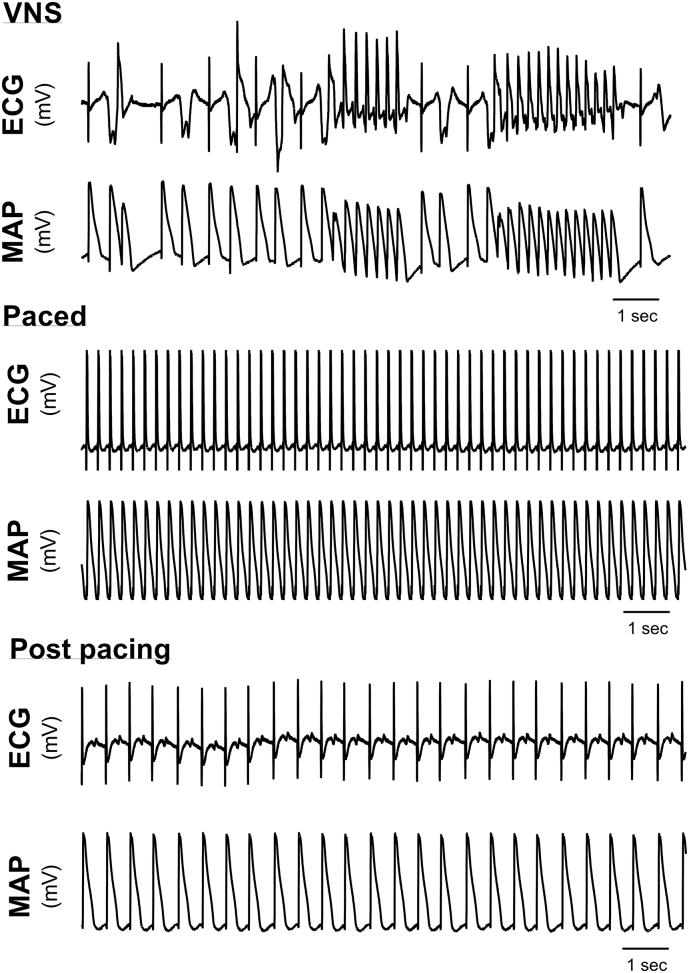
Suppression of VNS triggered arrhythmias by rapid pacing. Representative traces showing spontaneous episodes of early afterdepolarisations and ventricular tachycardia following vagus nerve stimulation (VNS), with subsequent rapid ventricular pacing (cycle length = 190 ms) and on the cessation of pacing (following 1-min of sustained pacing).